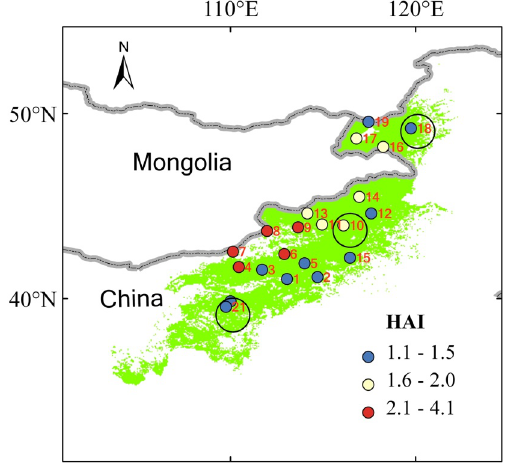
Fig. 4. The Holdridge aridity index of meteorological stations in Inner Mongolia grassland.